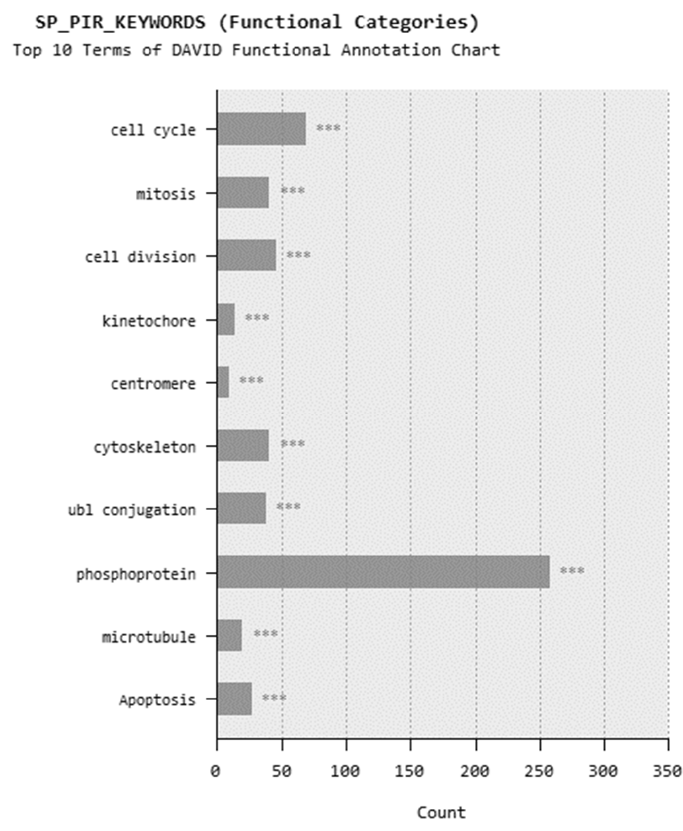
Figure 7. DAVID functional annotation analysis for cobalt boride (Co 2 B) NP application for func ‐ tional categories. p ‐ value < 0.001 (***).